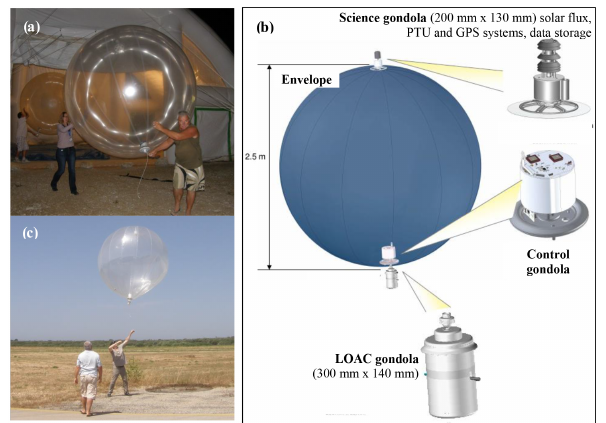
Figure 13. LOAC measurements inside a dust plume under the low tropospheric pressurized balloon during the ChArMEx campaign from Minorca, towards French coasts on 17 June 2013; the altitude was of 2000m; the uncertainty (at 1 σ ) is of about ± 20% for con- centrations higher than 10 − 1 cm − 3 up to ± 60% for concentrations lower than 10 − 2 cm − 3 . No obvious sedimentation of the particles was detected during the